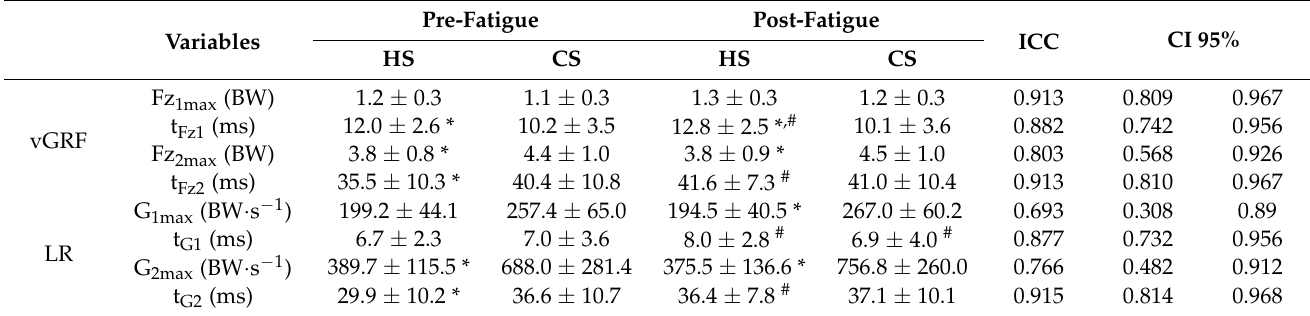
Table 1. Vertical GRF (vGRF) and loading rate (LR) of the lower extremity based on shoe conditions in pre-fatigue and post-fatigue.